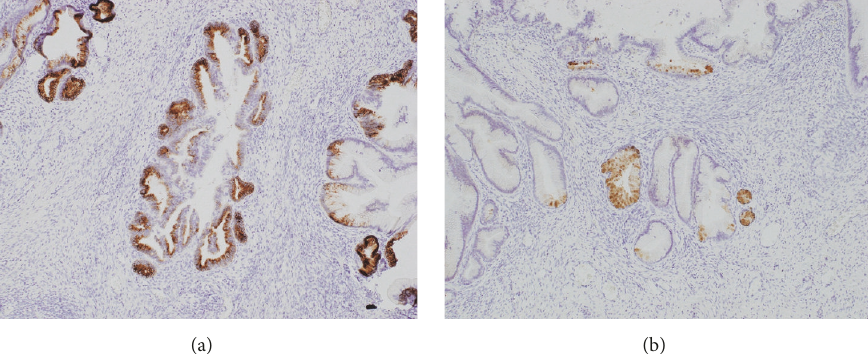
Figure 5: Immunohistochemical results. (a) MUC6 stain. Tumor cells were partially positive. (b) HIK1083 stain. Tumor cells were focally